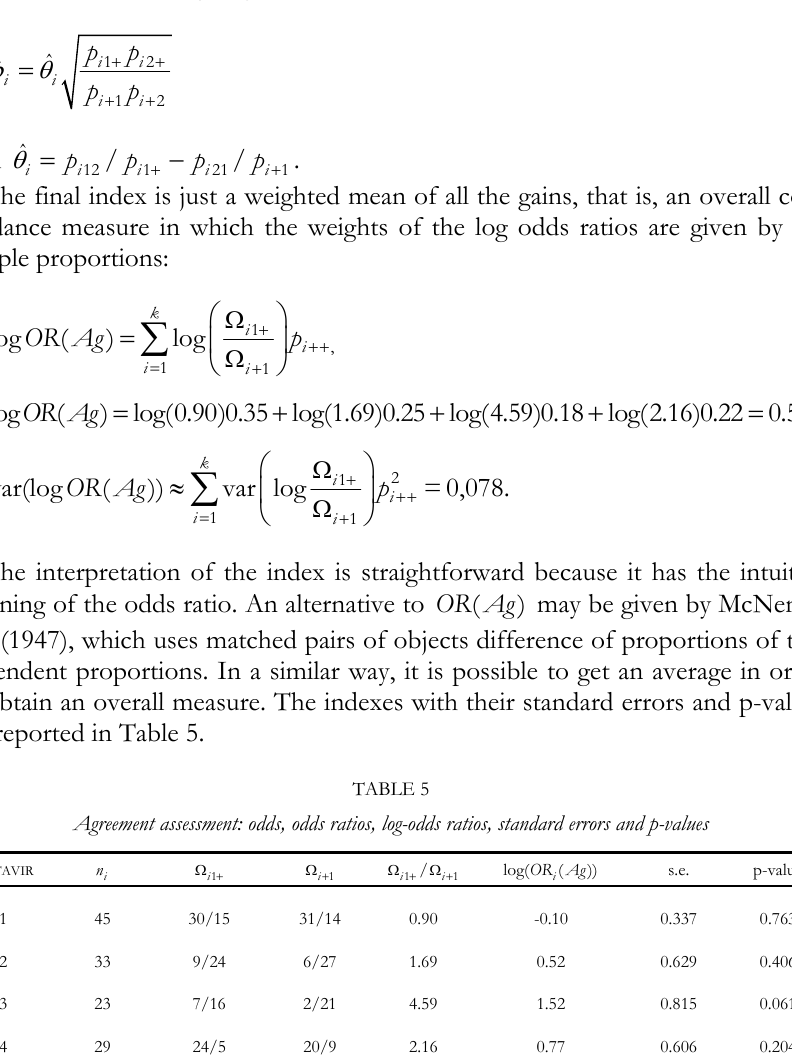
= 0.54, representing the overall “gain”of ARFI compared to TE , has the smallest standard